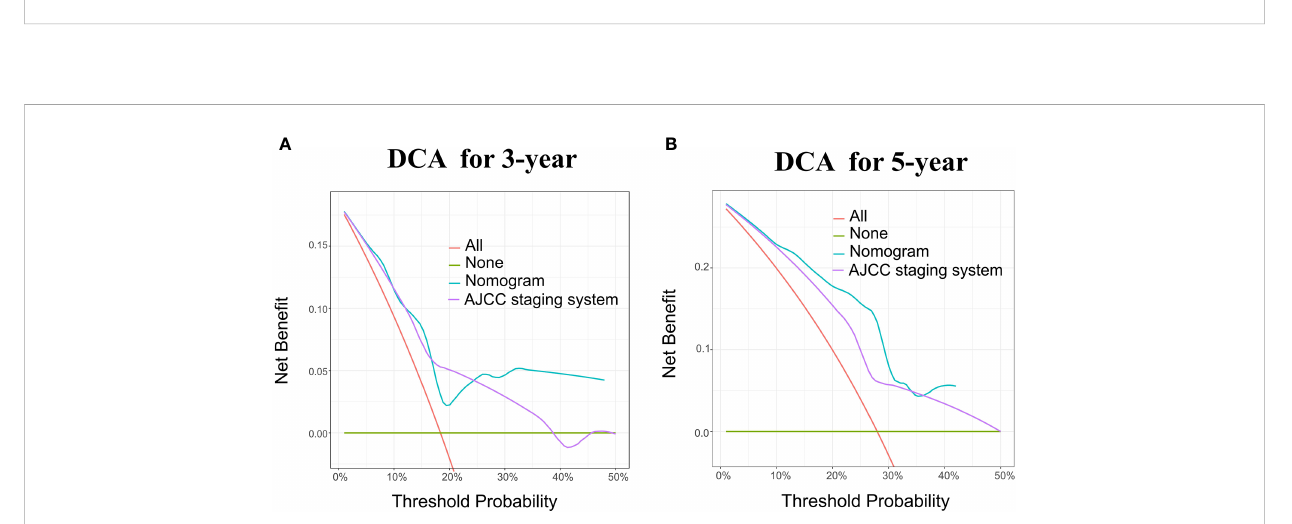
FIGURE 9 DCA for the Nomogram and AJCC staging system in the validation cohort. DCA in the prediction of patients at 3-year (A) and 5-year (B) in the training and validation II